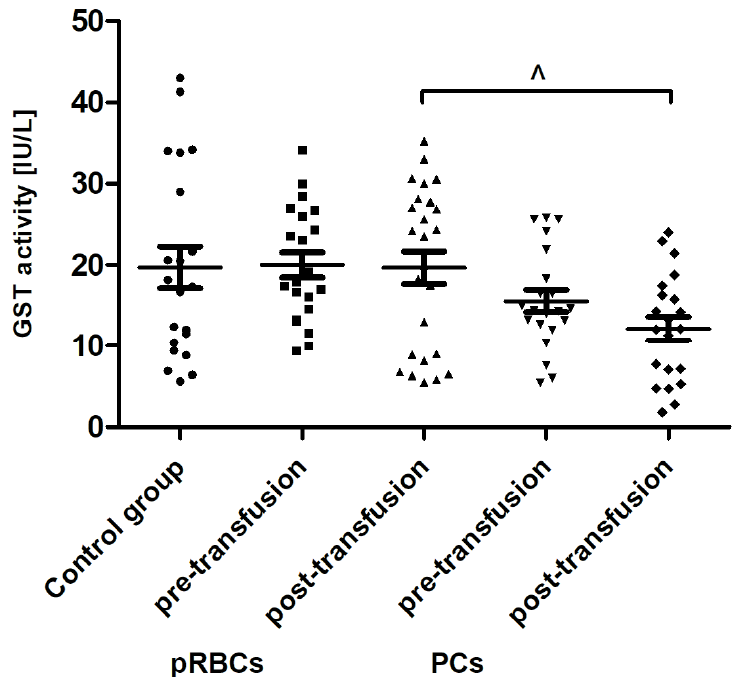
Figure 8. The activity of plasma GST in healthy volunteers (control group) and AML patients before and after transfusion of the blood component. Scatter plots show all of the data values obtained. Data are presented as mean ± SE. ˆ p < 0.05 compared post-transfusion pRBCs versus PCs; statistically significant according to the Tukey test. pRBCs—packed red blood cells; PCs— platelet concentrates.